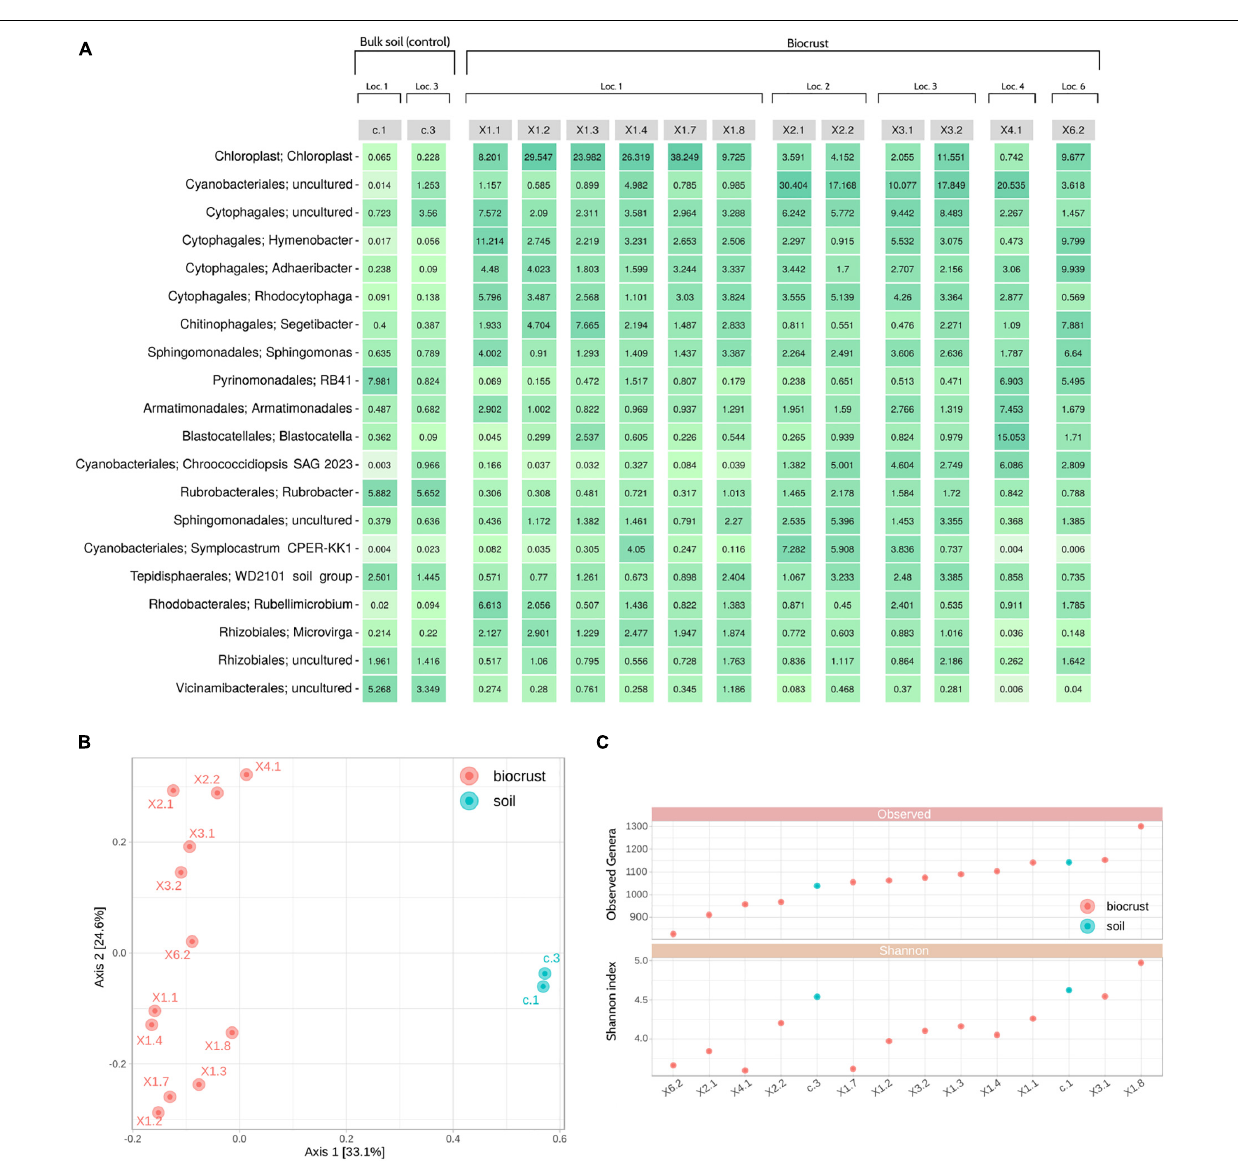
FIGURE 2 | Nanopore sequencing results. (A) Heatmap showing the top 20 genera detected in the samples and their relative abundances. (B) Principal Coordinates Analysis (PCoA) using the Bray-Curtis dissimilarity metric. (C) Alpha diversity analysis: Observed genera (richness) (top); Shannon index (bottom). Samples are ordered by richness. Loc,